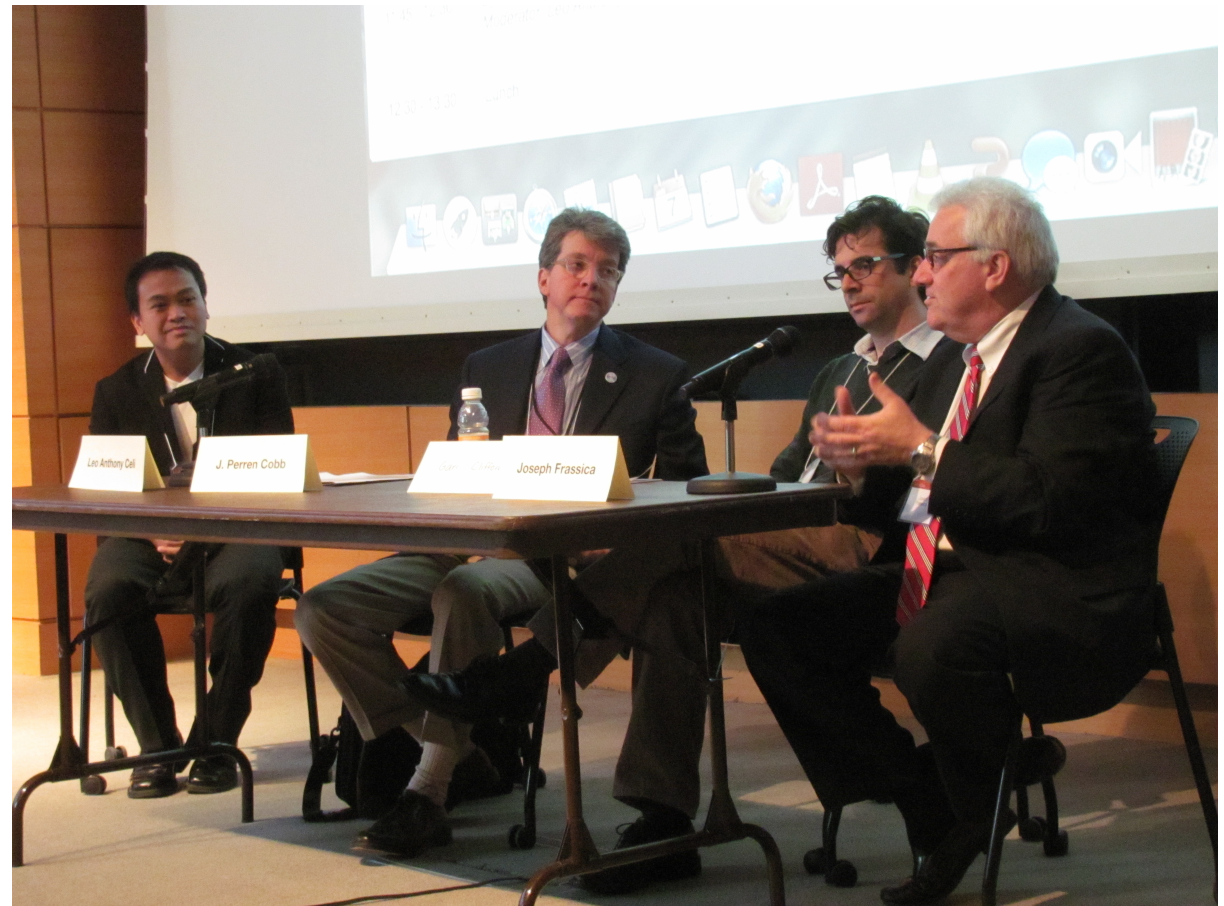
Figure 3. Data-driven learning system panel. Photo credit: Andrew